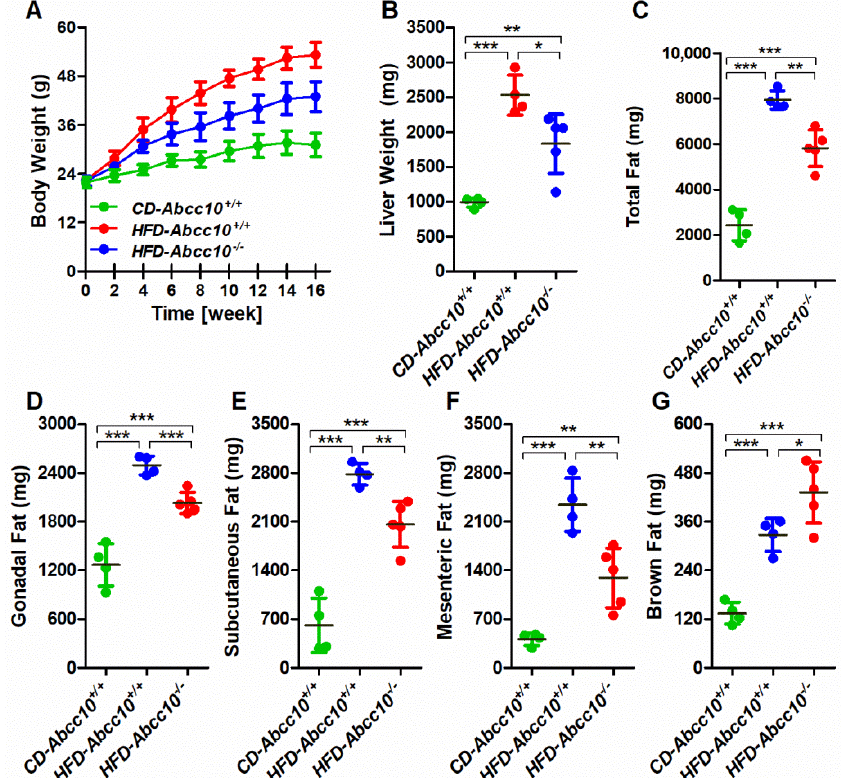
Figure 2. Ablation of ABCC10 in mice prevents diet-induced obesity. Eight-week-old Abcc10 +/+ ( HFD-Abcc10 +/+ , n = 4) and Abcc10 − / − ( HFD-Abcc10 − / − , n = 5) male mice were fed high-fat obesity diet for 16 weeks. As a control, age-matched Abcc10 +/+ ( CD-Abcc10 +/+ , n = 4) male mice were kept on chow diet during this period. Body weight of animals was recorded every two weeks ( A ). At the end of the experiment, mice were fasted overnight and sacrificed. Liver weight ( B ), total fat ( C ), gonadal fat ( D ), sub-cutaneous fat ( E ), mesenteric fat ( F ), and brown fat ( G ) were measured. Values are plotted as replicates (mean ± SD). * p < 0.05, ** p < 0.01, and *** p < 0.001.